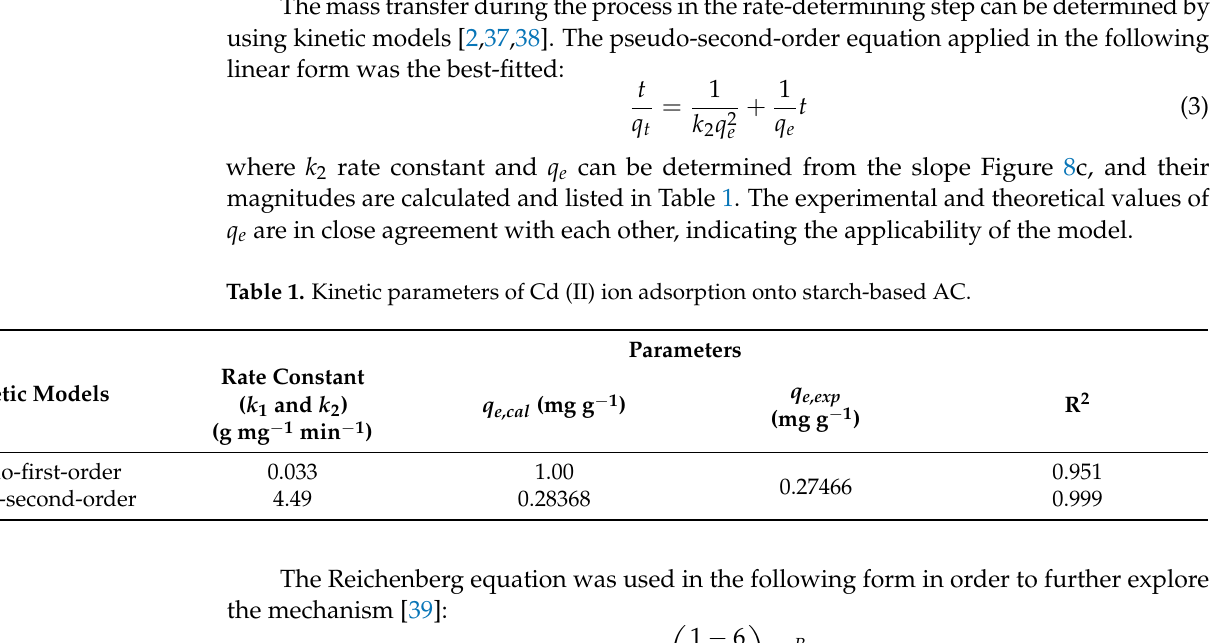
Figure 8. ( a ) Effect of amount of AC, ( b ) effect of shaking time, ( c ) pseudo-second-order kinetic model, and ( d ) Reichenberg model.